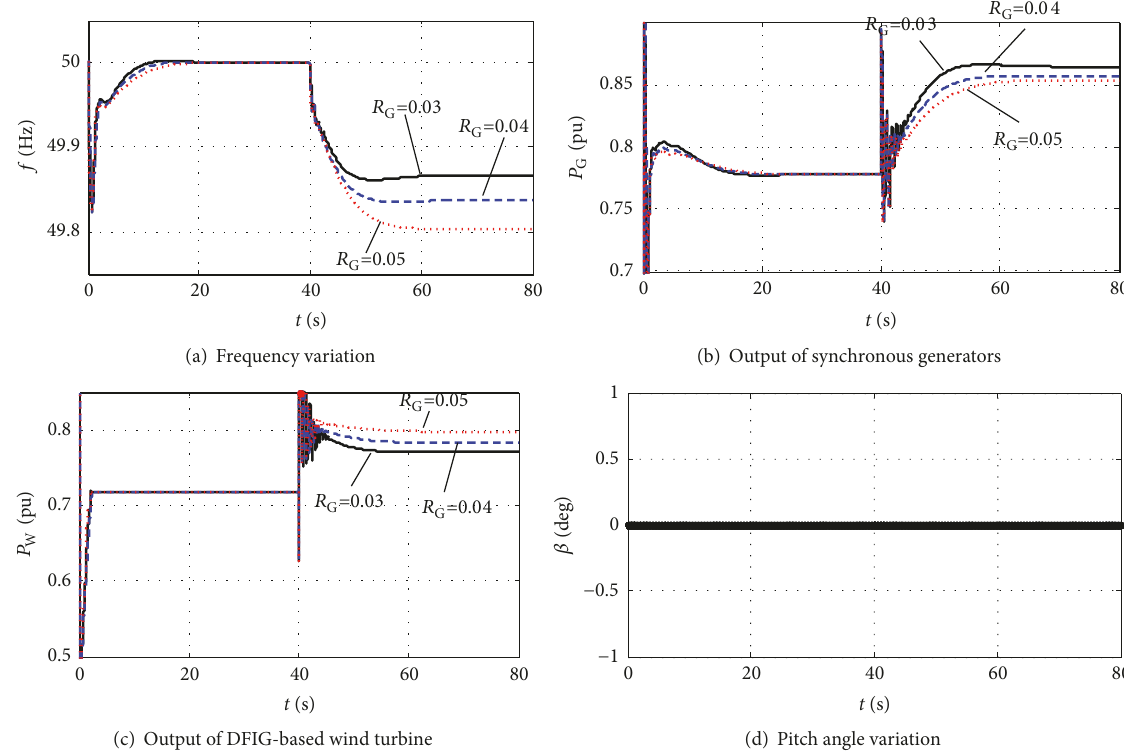
Figure 6: Simulation results of the maximum power tracking area when frequency change is less than